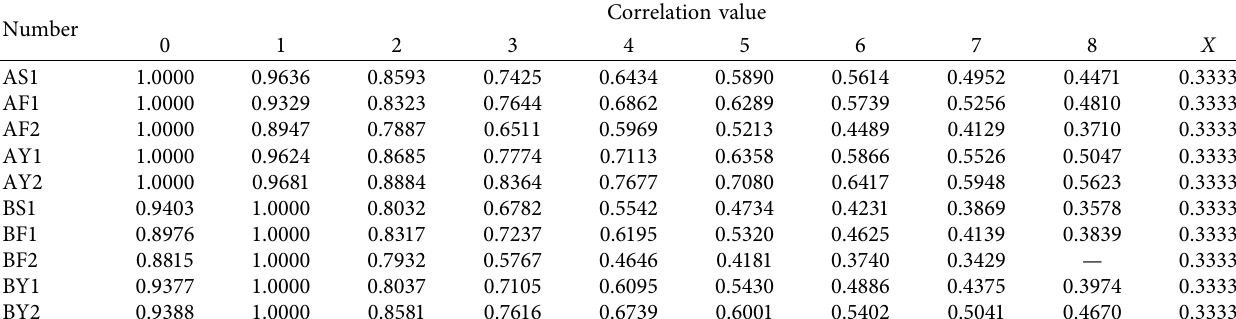
Table 5: Correlation value of each test group in water and compound salt solution.